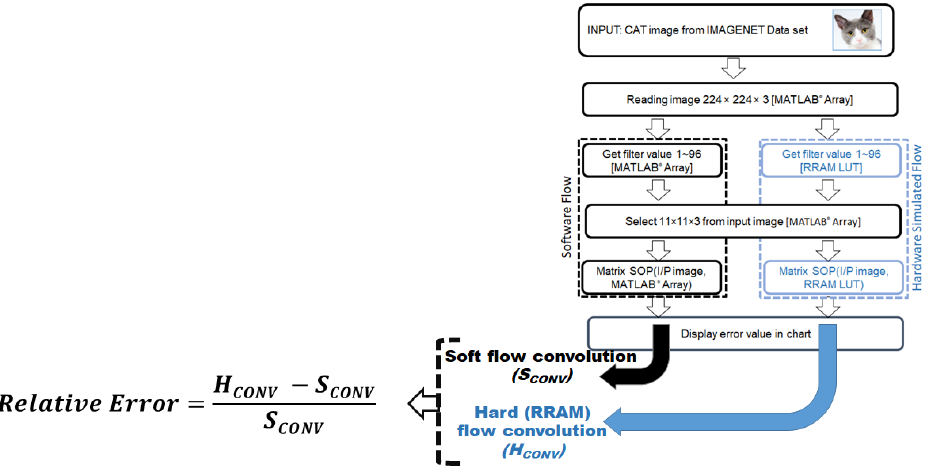
Figure 15. Definition of the relative error (RE) in computed matrix sum of products for the software and hardware flow convolution pipeline. The software pipeline refers to the algorithm trained weights while the hardware pipeline refers to the binary data encoded from the measured RRAM resistance distributions.